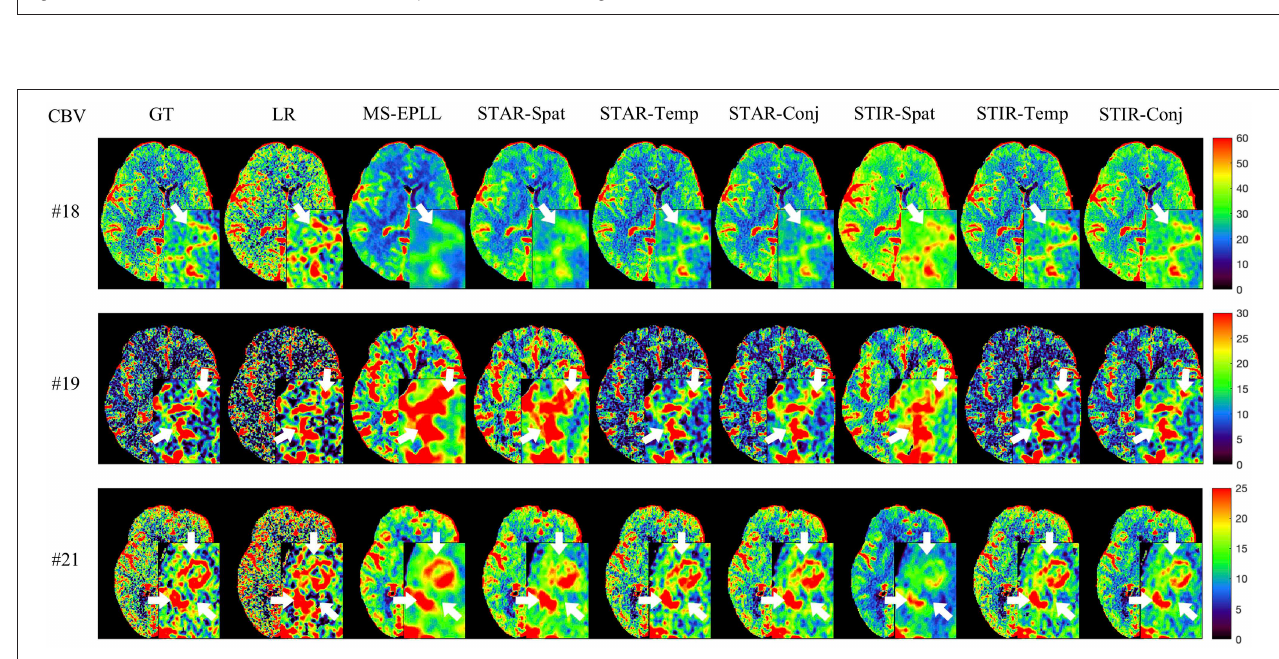
FIGURE 6 | Visual comparison of CBV for three test patients: #18, #19, and #21, when reducing the tube current to 40 mAs with a down-sample ratio of three (three times low spatial and two time low temporal resolutions). The notation for each column is: GT, Ground truth image; LR, Low-Resolution input; MS-EPLL, MS-EPLL restoration result; STAR-Spat, STAR reconstruction result (spatial only); STAR-Temp, STAR reconstruction result (temporal only); STAR-Conj, STAR reconstruction result (spatial + temporal); STIR-Spat, STIR-Net reconstruction result (spatial only); STIR-Temp, STIR-Net reconstruction result (temporal only); STIR-Conj, STIR-Net reconstruction result (spatial + temporal). All figures are displayed by using the same colormap and the color range for each patient is shown in the colorbar on the rightmost of each row. We use white arrows to compare the details in the region of interests.